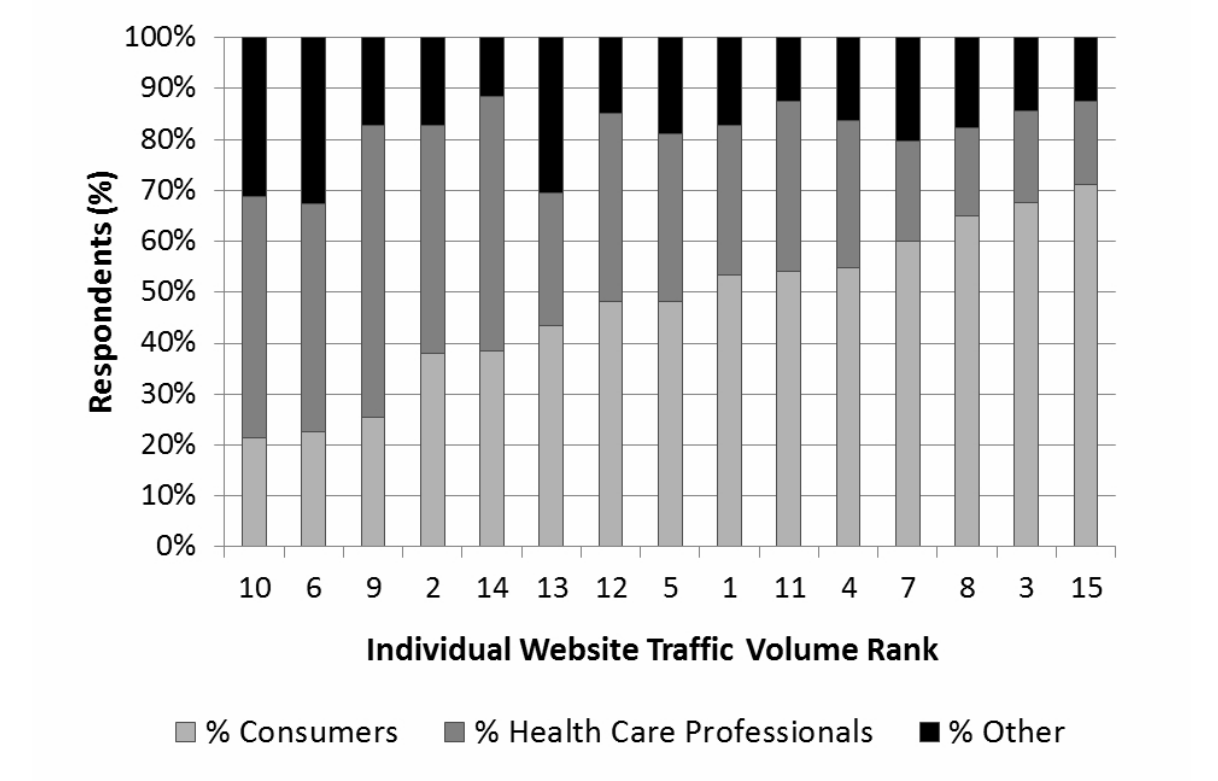
Figure 2. Variation in proportions of consumer and health care professional respondents across